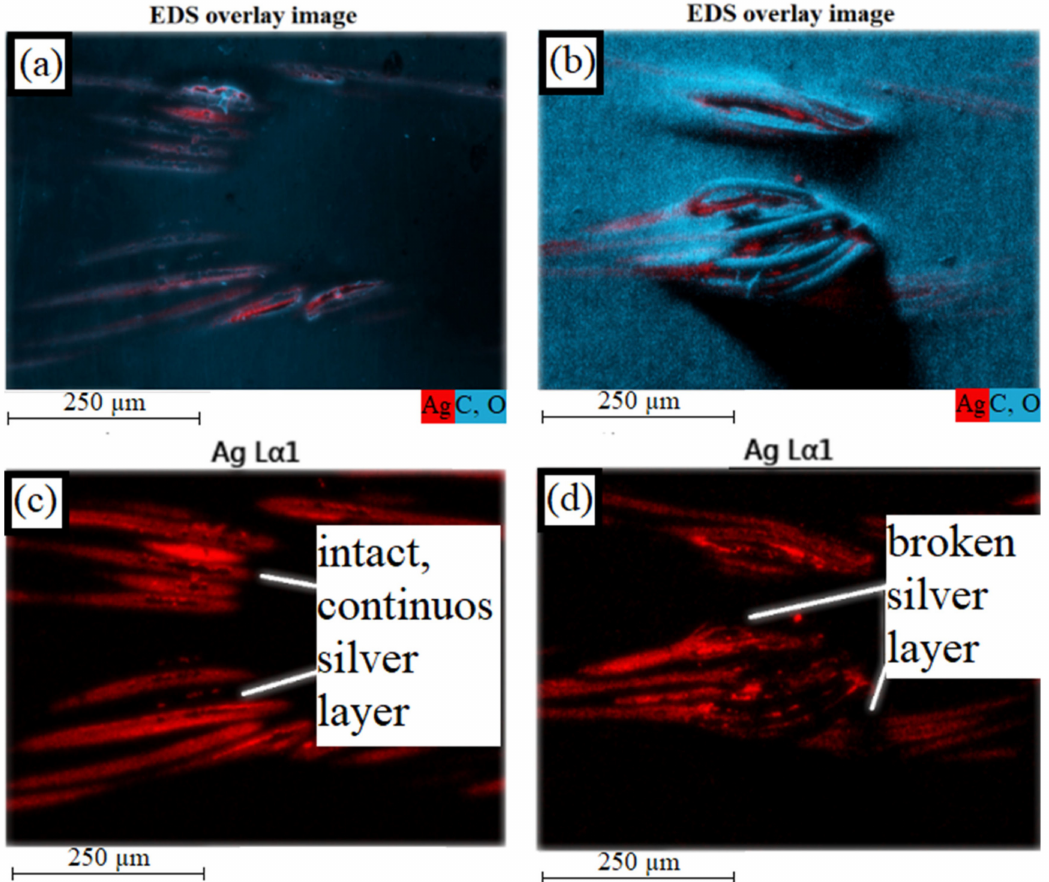
Figure 14. EDS overlay image of knitted sample (silver in red, polymer in blue): ( a ) untested; ( b ) loaded; EDS overlay image of knitted sample (only silver): ( c ) untested; ( d )